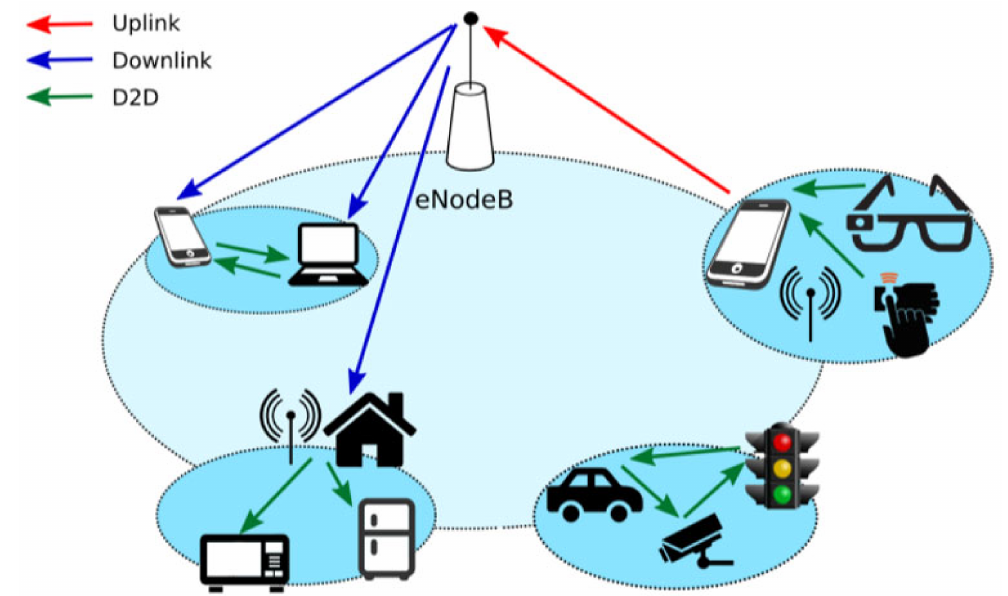
Figure 1. A general scenario of D2D communication-based 5G IoT